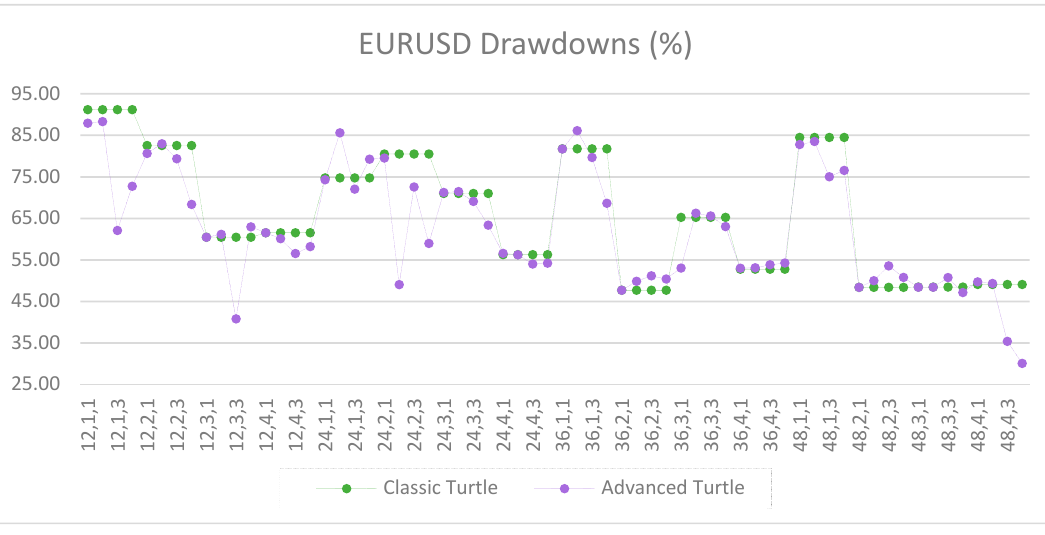
Figure A20. Drawdowns of EURUSD as percentage of equity between the classic and the advanced Turtle systems for every combination of N, X, Y for the medium parameters (40, 80).